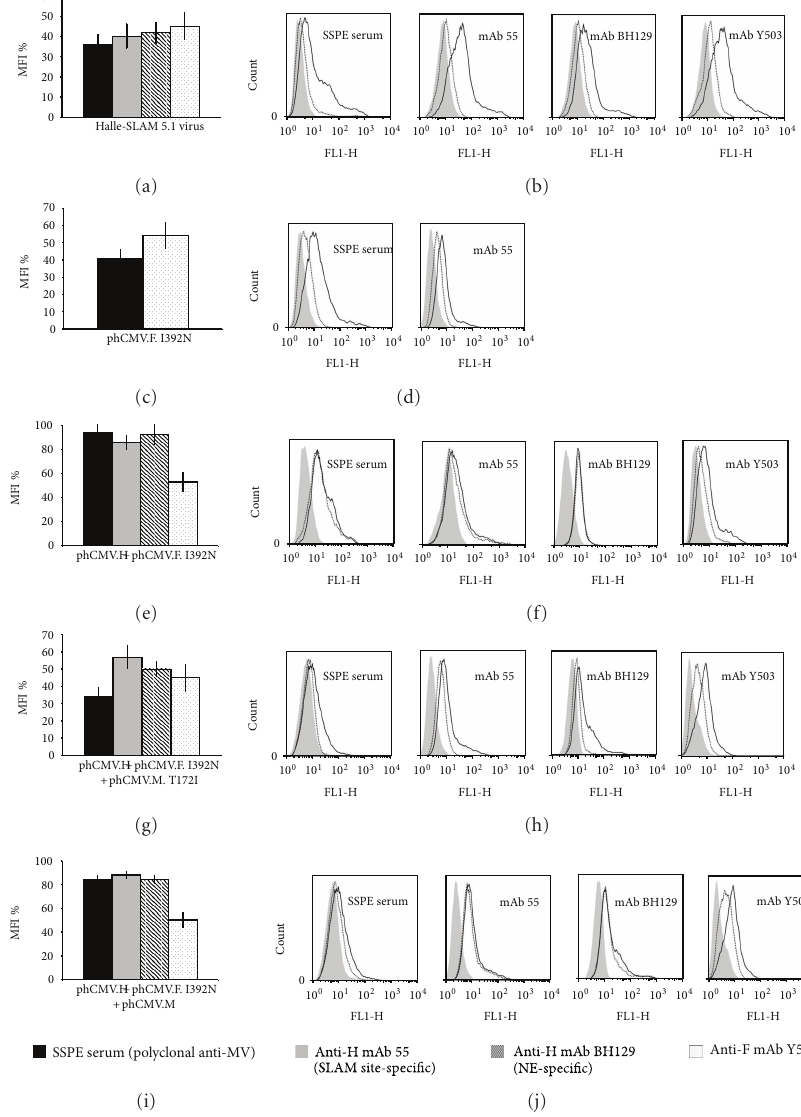
Figure 7: Flow cytometry analysis of escape mutant Halle-SLAM 5.1 (H: no change; F: I329N; M: T172I). Vero-SLAM cells infected with the escape mutant virus or transfected with various phCMV plasmids in the presence, when necessary, of the antifusion tri-peptide FIP were analysed 1 day after infection (or after transfection) using the indicated antibodies. Each overlay histogram represents one experiment; the MFI histogram data represent the mean percentages ± standard deviations for three experiments. These values were obtained by using nonmutated Halle virus or expressed nonmutated Halle proteins as controls. (a) and (b) Cells infected with escape mutant Halle-SLAM 5.1; (c) and (d) cells transfected with phCMV.F.I329N; ((e) and (f)) cells cotransfected with phCMV.F.I329N + phCMV.H; ((g) and (h)) and ((i) and (j)), cells cotransfected with phCMV.F.I329N + phCMV.H + phCMV.M.T172I or phCMV.M,